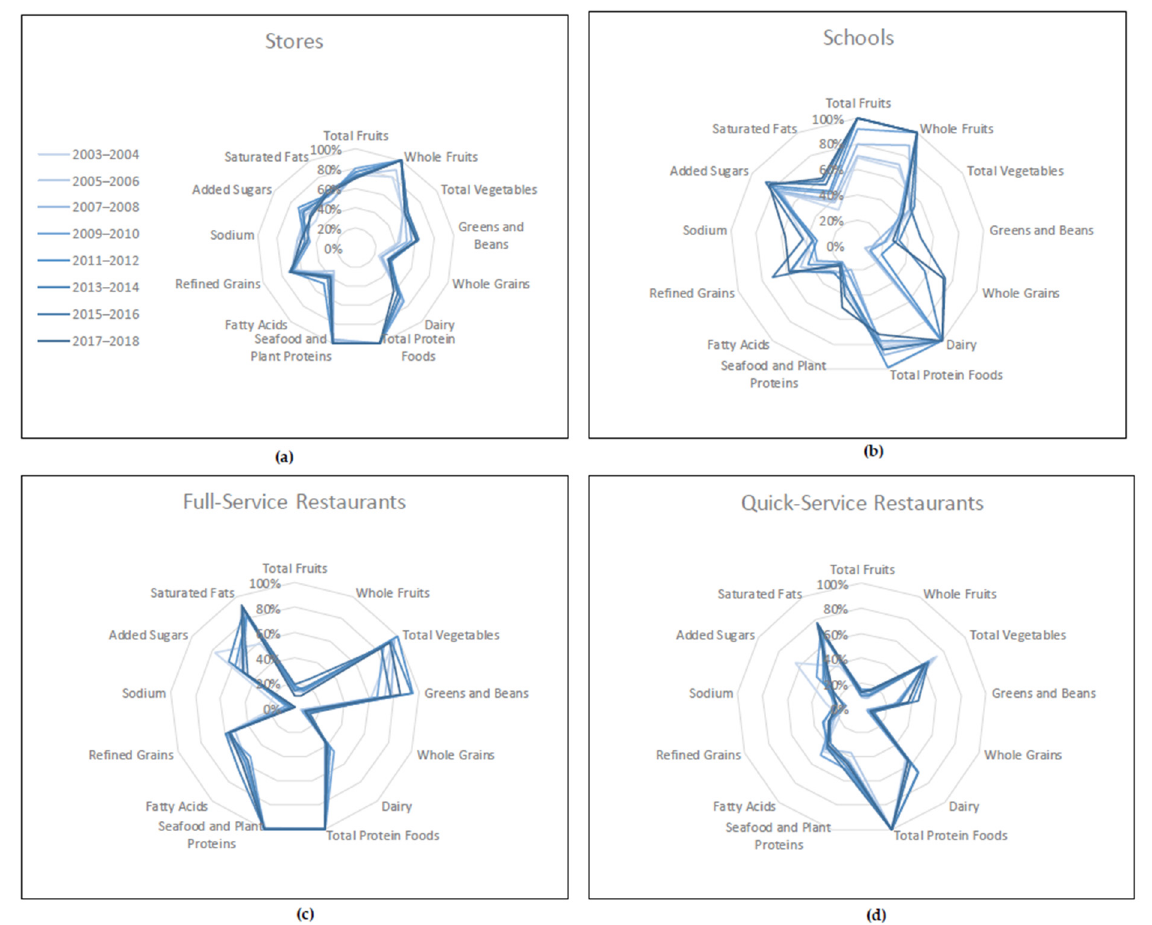
Figure 3. Differences in HEI-2015 component scores over time by food outlet type. ( a ) HEI-2015 component scores for stores; ( b ) HEI-2015 component scores for schools; ( c ) HEI-2015 component scores for full-service restaurants; ( d ) HEI-2015 component scores for quick-service restaurants. On the radar plots, the center point of the graph represents a score of zero, and the outer point of each axis represents the maximum score for each component. Therefore, plots with most points closer to the outer edge represent a food pattern that is closer to meeting the recommendations of the 2015–2020 DGA than a plot with many points closer to the center of the graph. Additional information on HEI visualization and radar plots can be found on the NCI website and the HEI ‐ 2015 update paper [10,34].